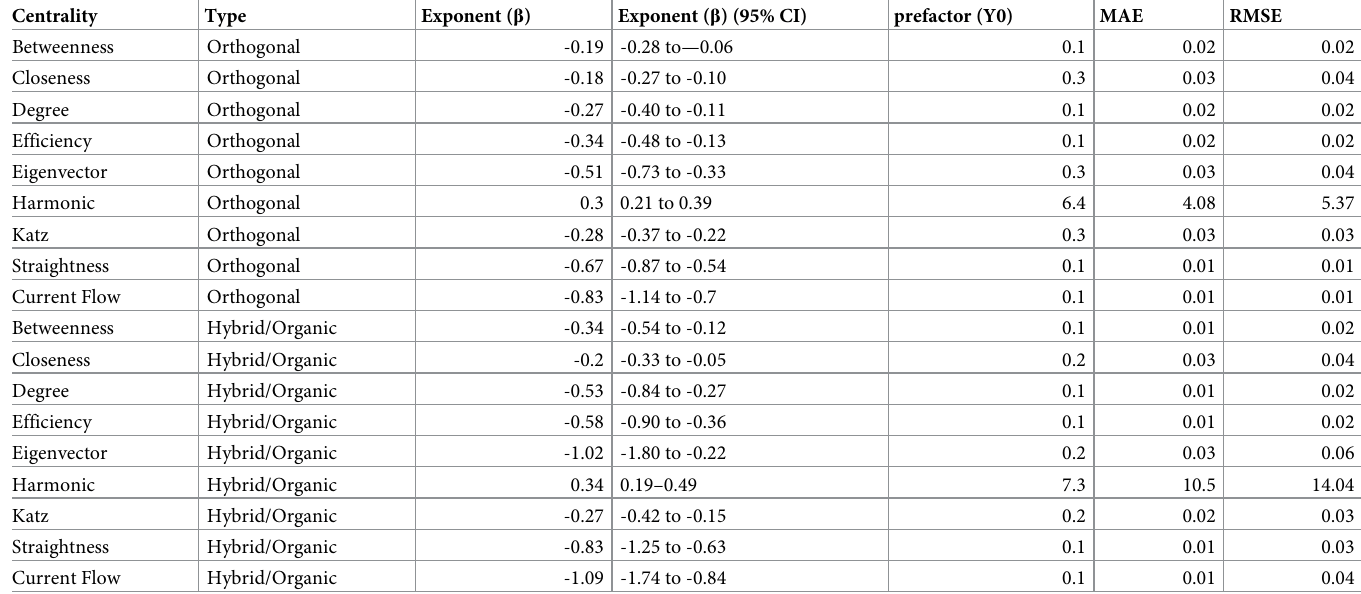
Table 2. Summary values showing β , CI for β , and MAE and RMSE for centrality/reciprocal centrality for orthogonal and hybrid/organic urban sites.